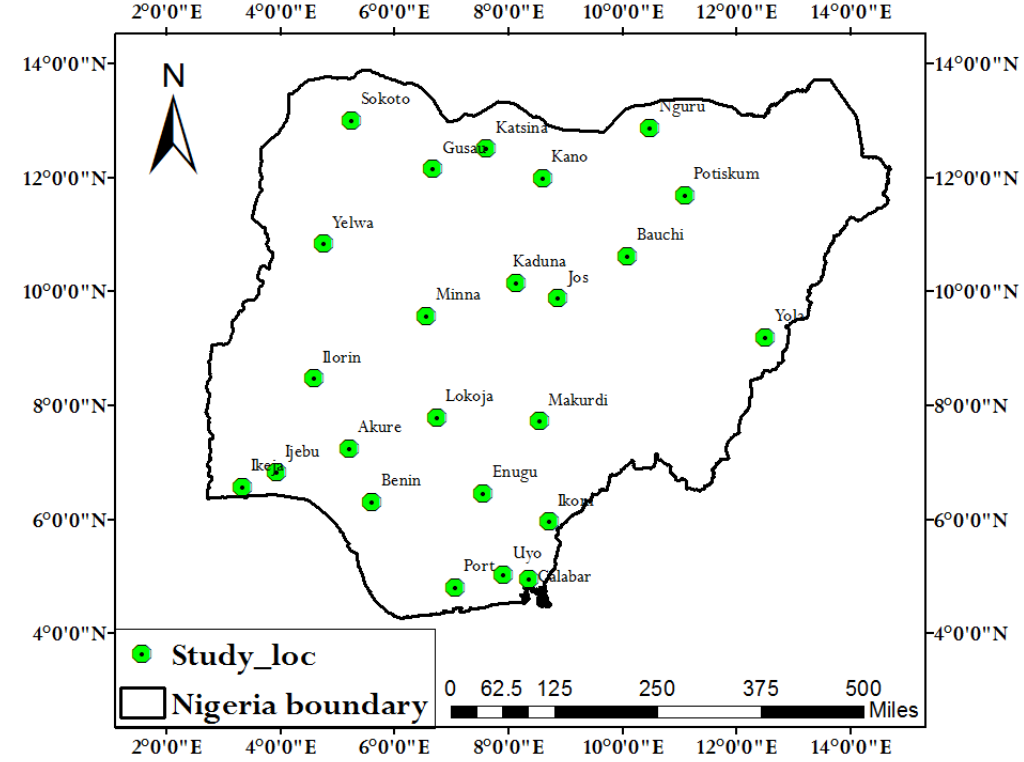
Figure 1. The study area indicating the meteorological stations used.